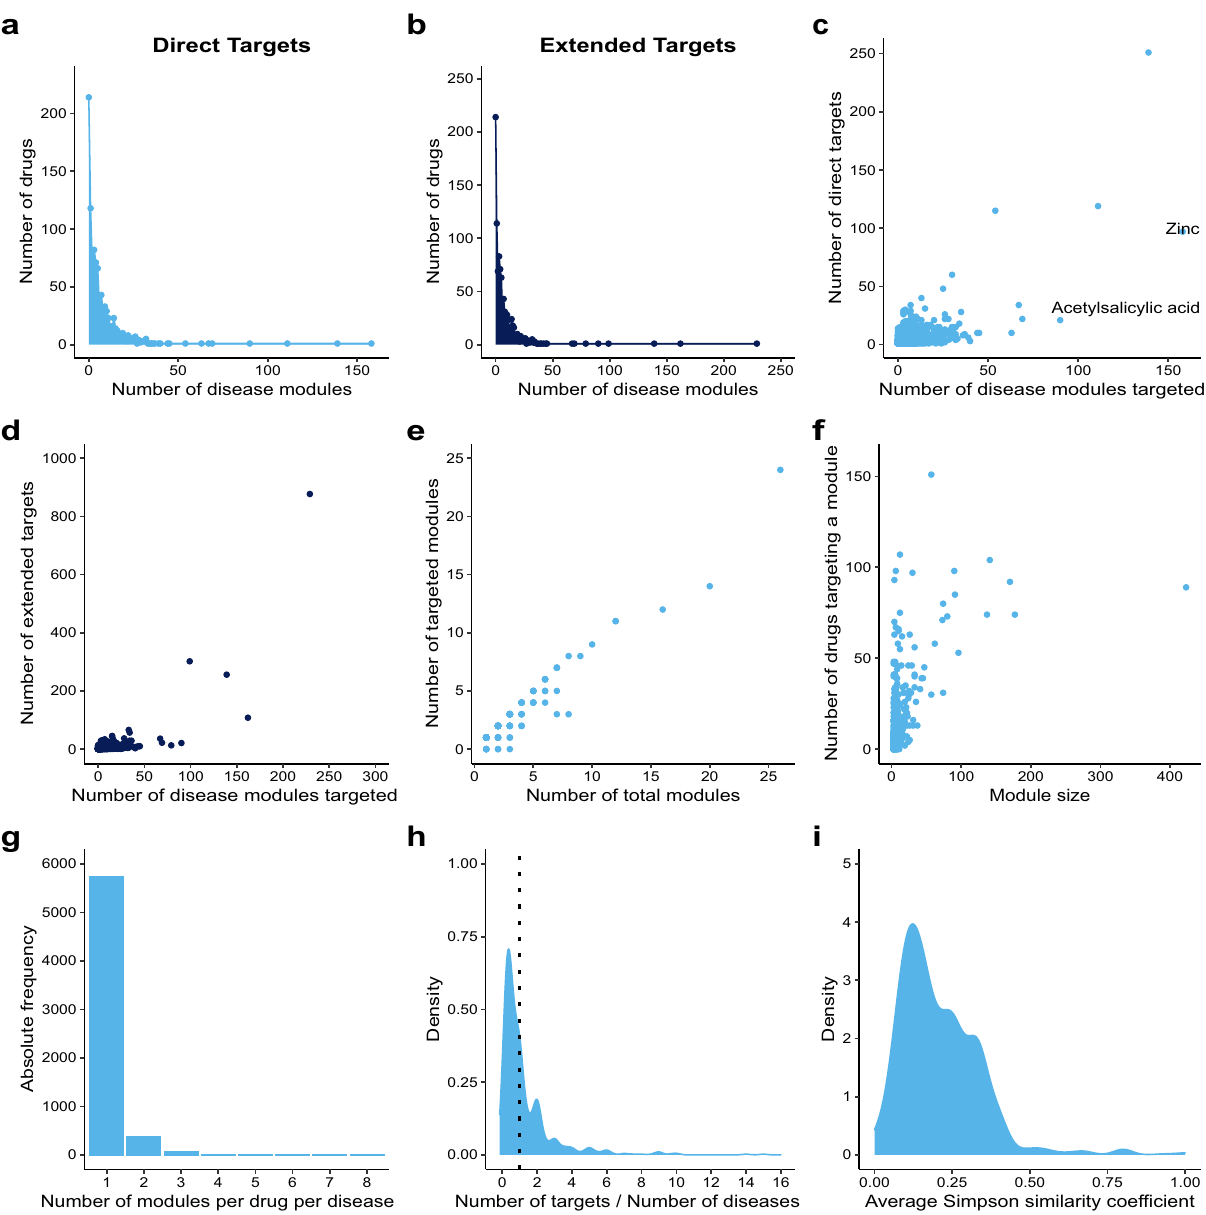
Figure 3. Most drugs target few modules. ( a ) Distribution of the number of modules targeted per drug considering the direct targets. ( b ) Distribution of the number of modules targeted per drug considering their extended targets. ( c ) Correlation between the number of disease modules targeted by a drug and its number of direct gene targets (rho = 0.495, p-value < 2.2 × 10 –16 ). ( d ) Correlation between the number of disease modules targeted by a drug and its number of extended gene targets (rho = 0.503, p-value < 2.2 × 10 –16 ). ( e ) Correlation between the total number of modules and the number of drug-targeted modules in a disease (rho = 0.903, p-value < 2.2 × 10 –16 ). ( f ) Correlation between the size of a disease module (number of genes) and the number of drugs targeting it (rho = 0.488, p-value < 2.2 × 10 –16 ). ( g ) Number of modules targeted per drug in a disease targeted by that drug. ( h ) Density plot of the number of direct targets per disease for all drugs (average ratio = 0.52). ( i ) Density plot of the Szymkiewicz–Simpson similarity coefficients between disease modules targeted by single drugs (average Szymkiewicz–Simpson similarity coefficient =